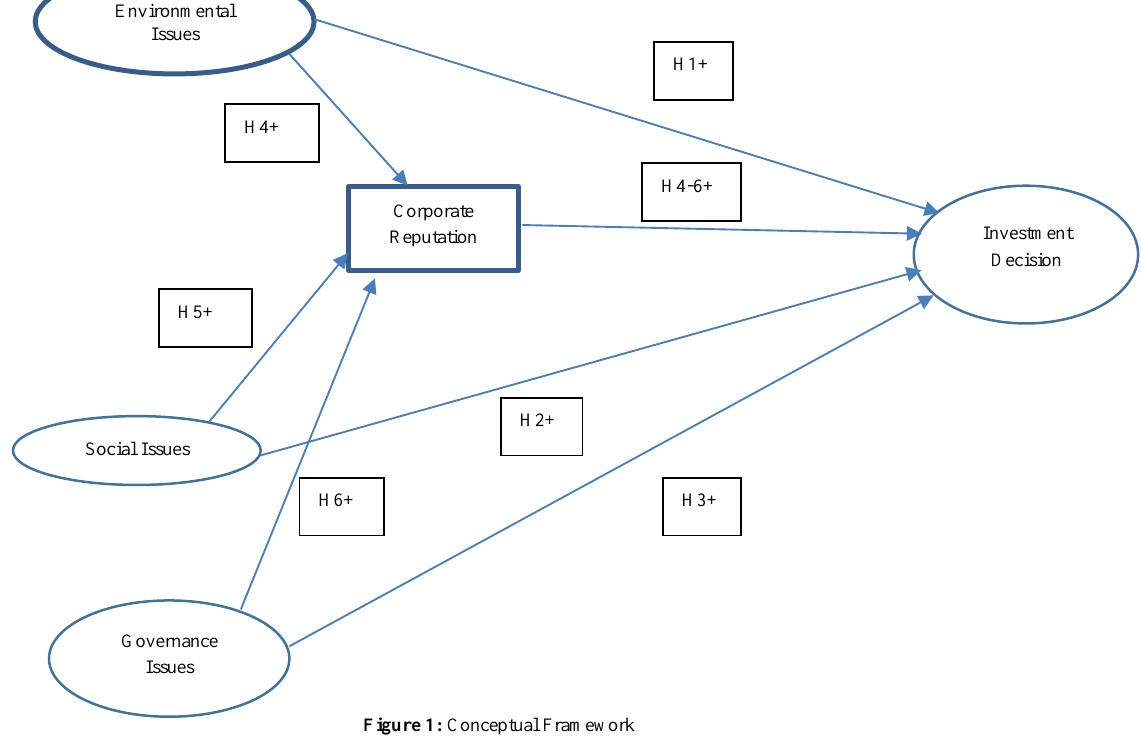
Figure 1: Conceptual